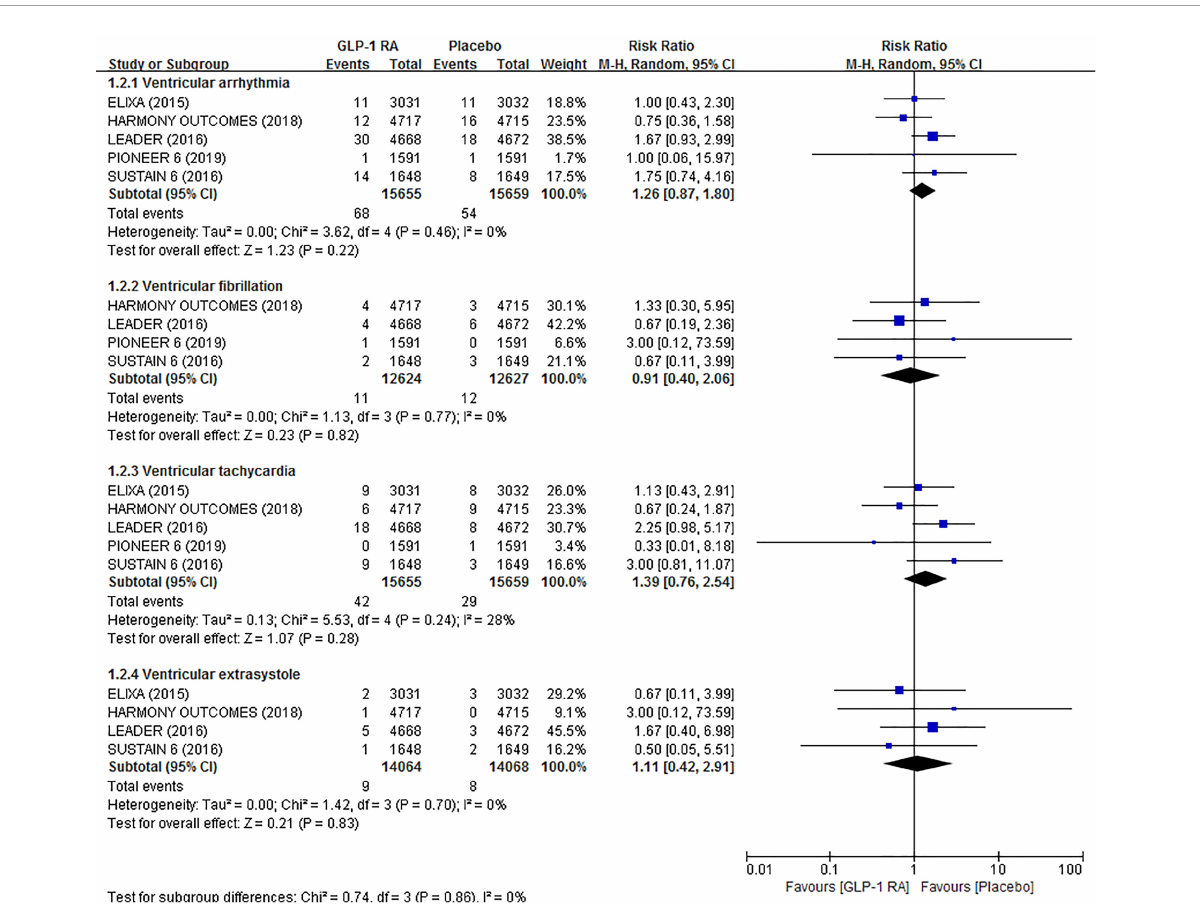
FIGURE3 Forest plot of the association between GLP-1RAs and the risk of ventricular arrhythmias compared with